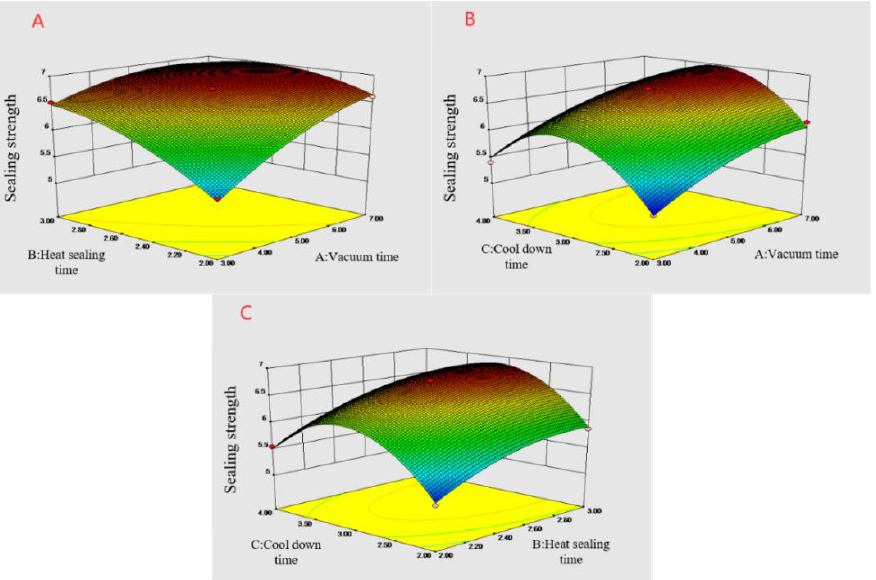
Figure 4. Response surface diagram of the influence of the interaction of various factors on the strength of the heat-sealing. ( A ) Vacuum time and heat-sealing time interaction; ( B ) vacuum time and cooling time interaction; and ( C ) heat-sealing time and cooling time interaction.